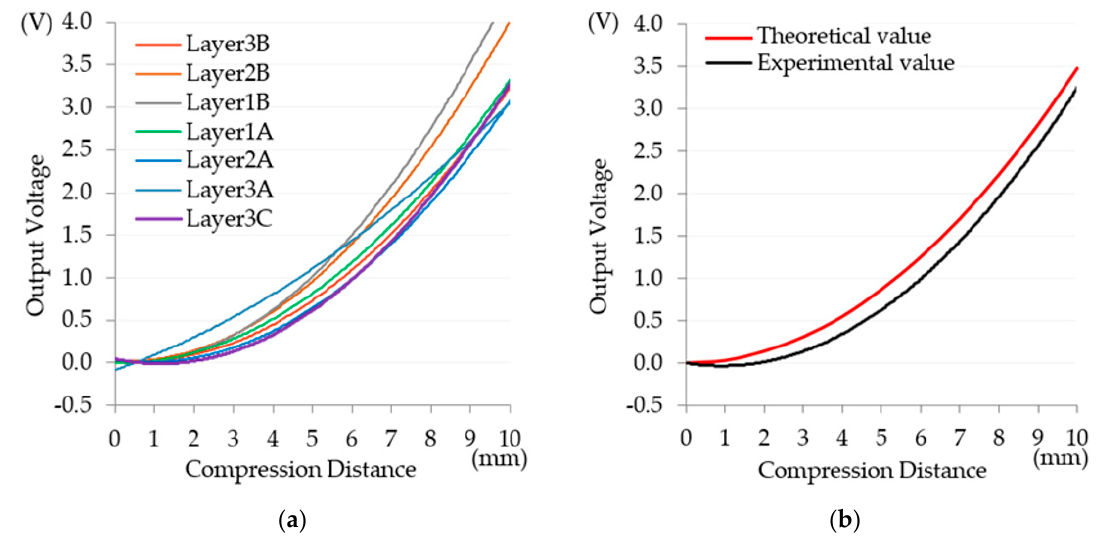
Figure 12. ( a ) Result analysis for Experiment B and ( b ) comparison between theoretical values and experimental values of Layer 3C.